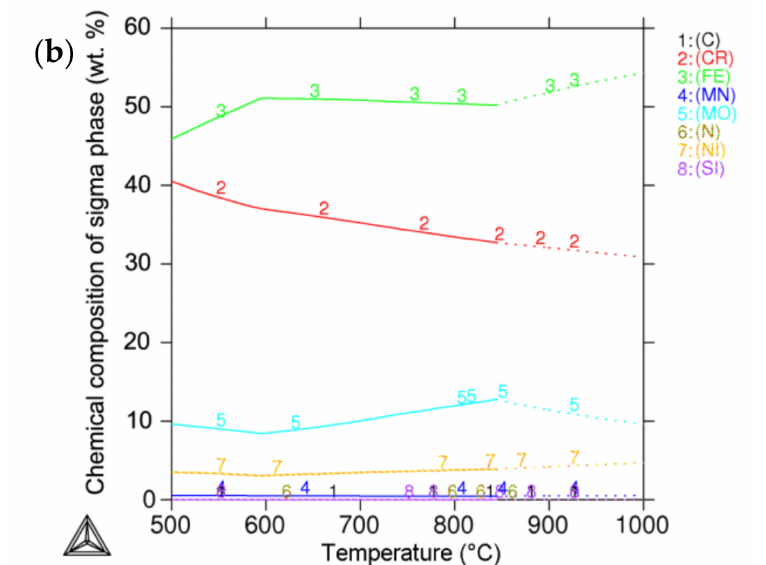
Figure 10. Influence of annealing temperature on chemical composition of predicted secondary phases in AISI 316L steel: ( a ) M 23 C 6 carbide; ( b ) sigma phase.